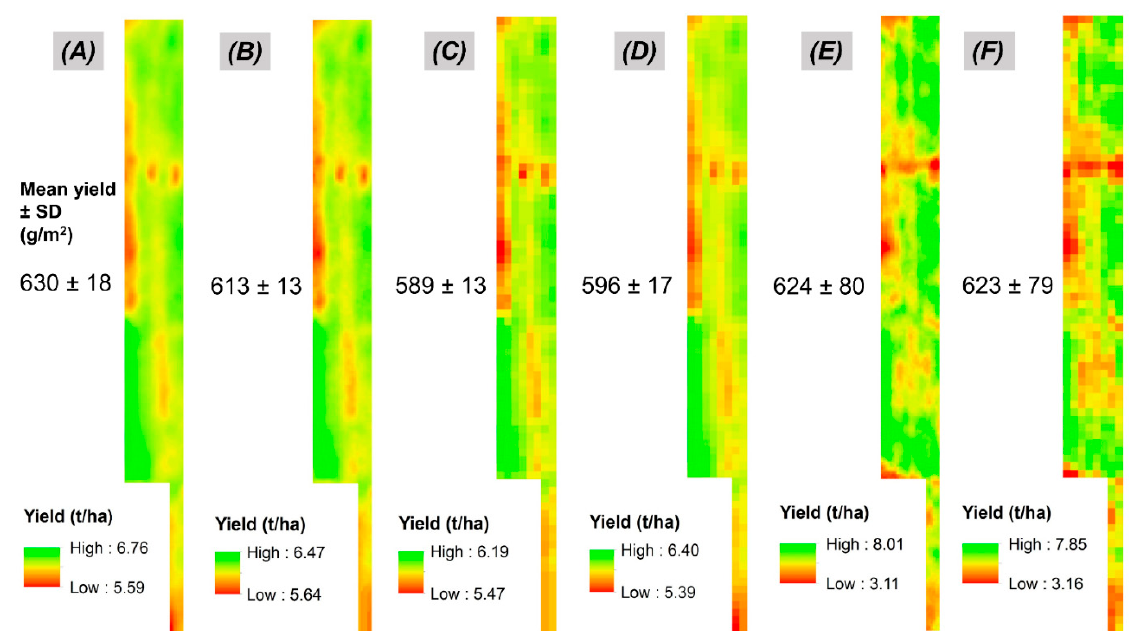
Figure 10. Spatial wheat yield map predicted by the SAFY model for four scenarios: ( A ) predicted yield using LAI derived from PS-S2 MSAVI fused image (55 images throughout the season); ( B ) reduced revisit time: the number of images was reduced to resemble the Sentinel-2 revisit time (10 images throughout the season); ( C ) reduced revisit time and spatial resolution: the number images were reduced to resemble the Sentinel-2 revisit time (n = 10), and images were resampled to the Sentinel-2 spatial resolution of 10 m; ( D ) reduced spatial resolution (n = 55): the images were resampled to the Sentinel-2 spatial resolution of 10 m; ( E ) observed yield interpolated to 3 m resolution; ( F ) observed yield interpolated to 10 m resolution.